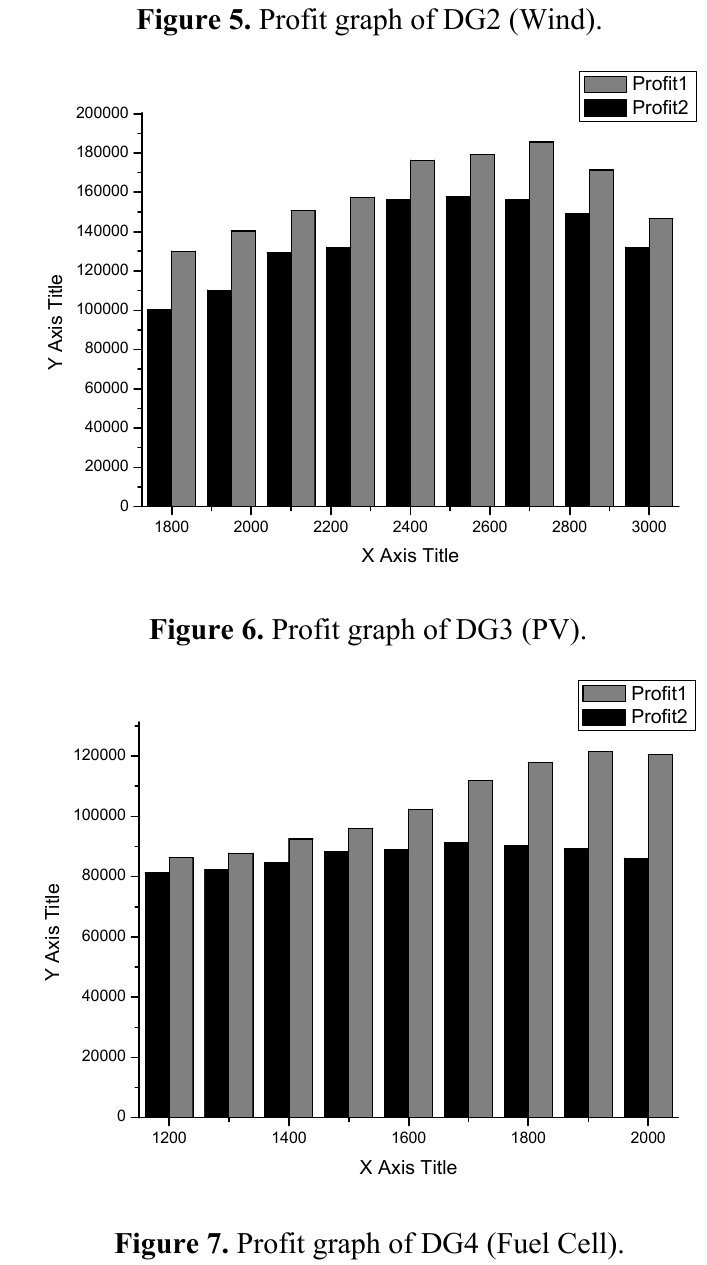
Figure 7. Profit graph of DG4 (Fuel